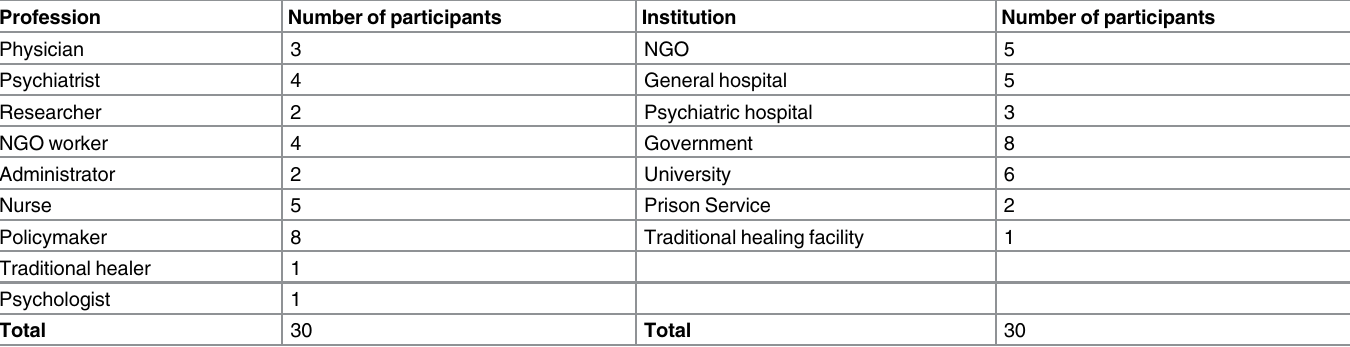
Table 1. Characteristics of interview